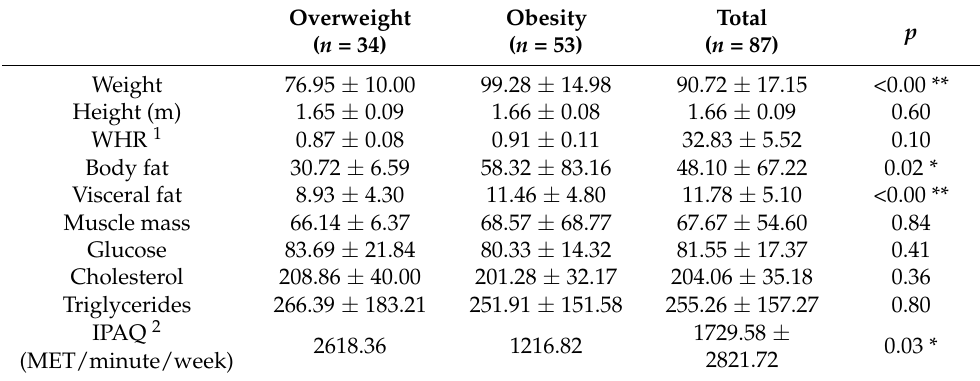
Table 2. Anthropometrics, body composition, and clinical parameters of participants ( n = 87).